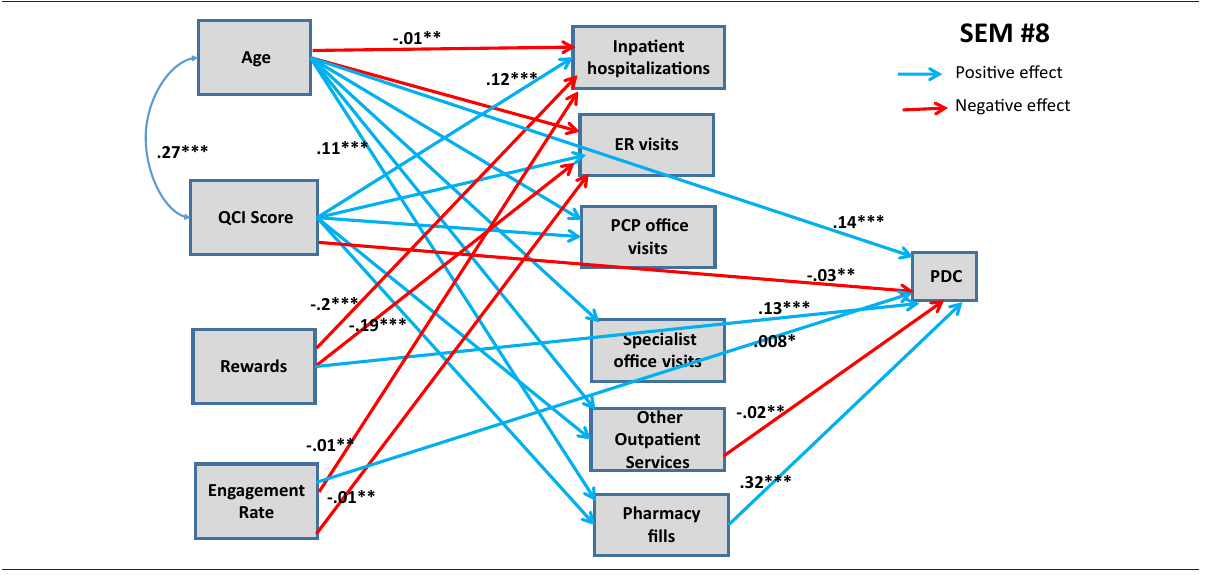
Figure 4. SEM #8 Presents Structural Determinants of PDC from HIRD Data and TRUSTR Social Media Experimental